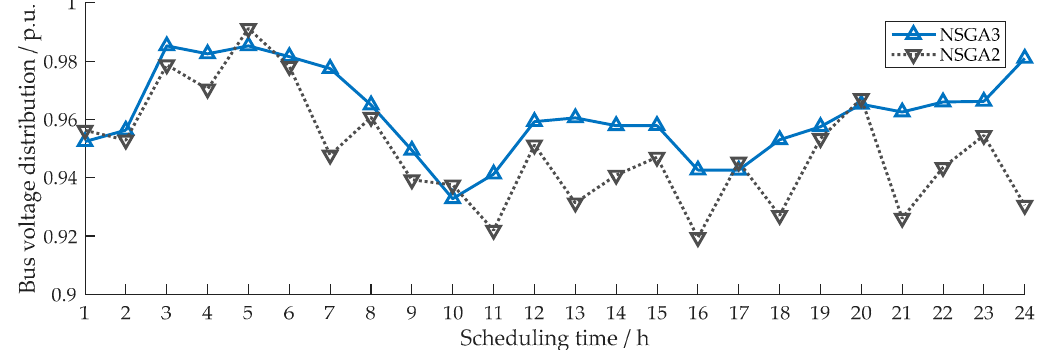
Figure 16. Comparison of minimum bus voltage of different algorithms.